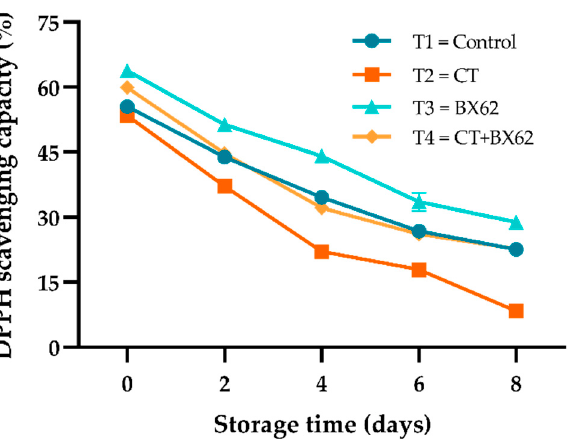
Figure 5. Changes in DPPH scavenging capacity for the control apples ( ● ), chitosan-treated apples ( ■ ), L. plantarum BX62-treated apples ( ▲ ), and chitosan in combination with L. plantarum BX62-treated apples ( ◆ ) after being stored at 4 °C for 8 days. Each data point is the mean of three replicate samples.